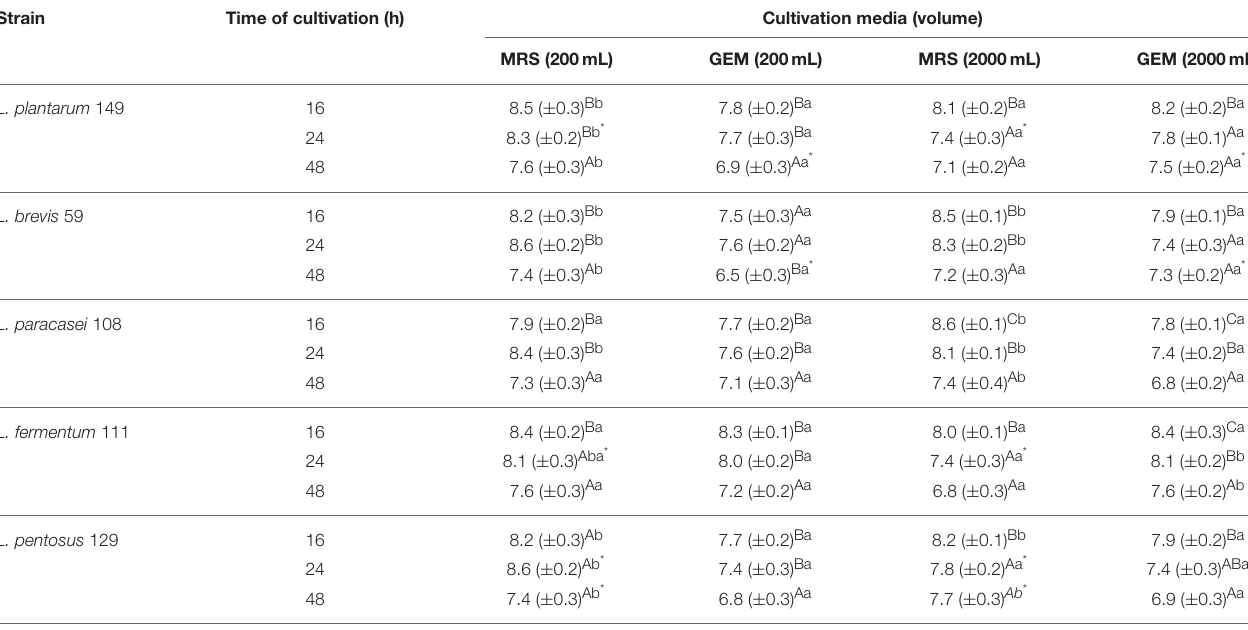
TABLE 5 | Viable cell counts ( n = 3, mean values ± standard deviation; log CFU/g) of lactobacilli isolates from pulp fruit byproducts when cultivated in de Man, Rogosa, and Sharpe (MRS) and in general edible medium (GEM) broths at low-scale (200mL) and medium-scale (2000mL) volumes at 37 ◦ C during 48h (initial viable cell counts of approx. 7 log CFU/mL).